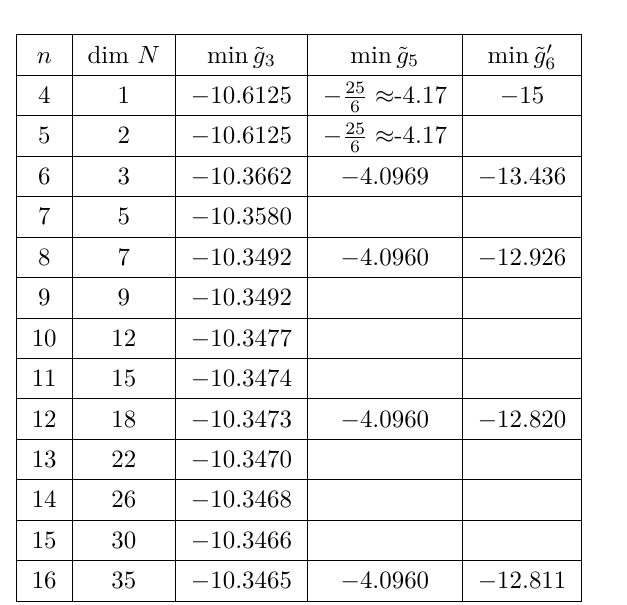
Table 1. Nonperturbative (possibly non-optimal) upper bounds on dimensions.